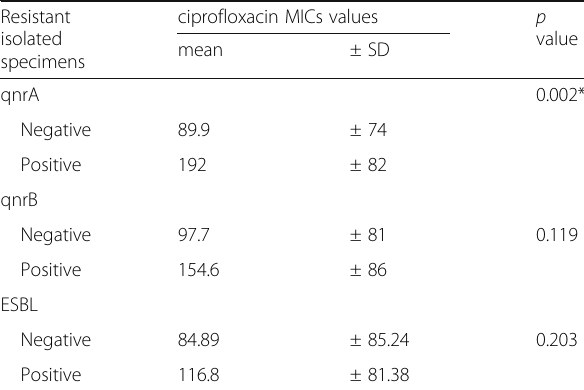
Table 5 ciprofloxacin MICs values of qnr A and qnr B genes positive quinolone resistant isolated specimens Resistant isolated